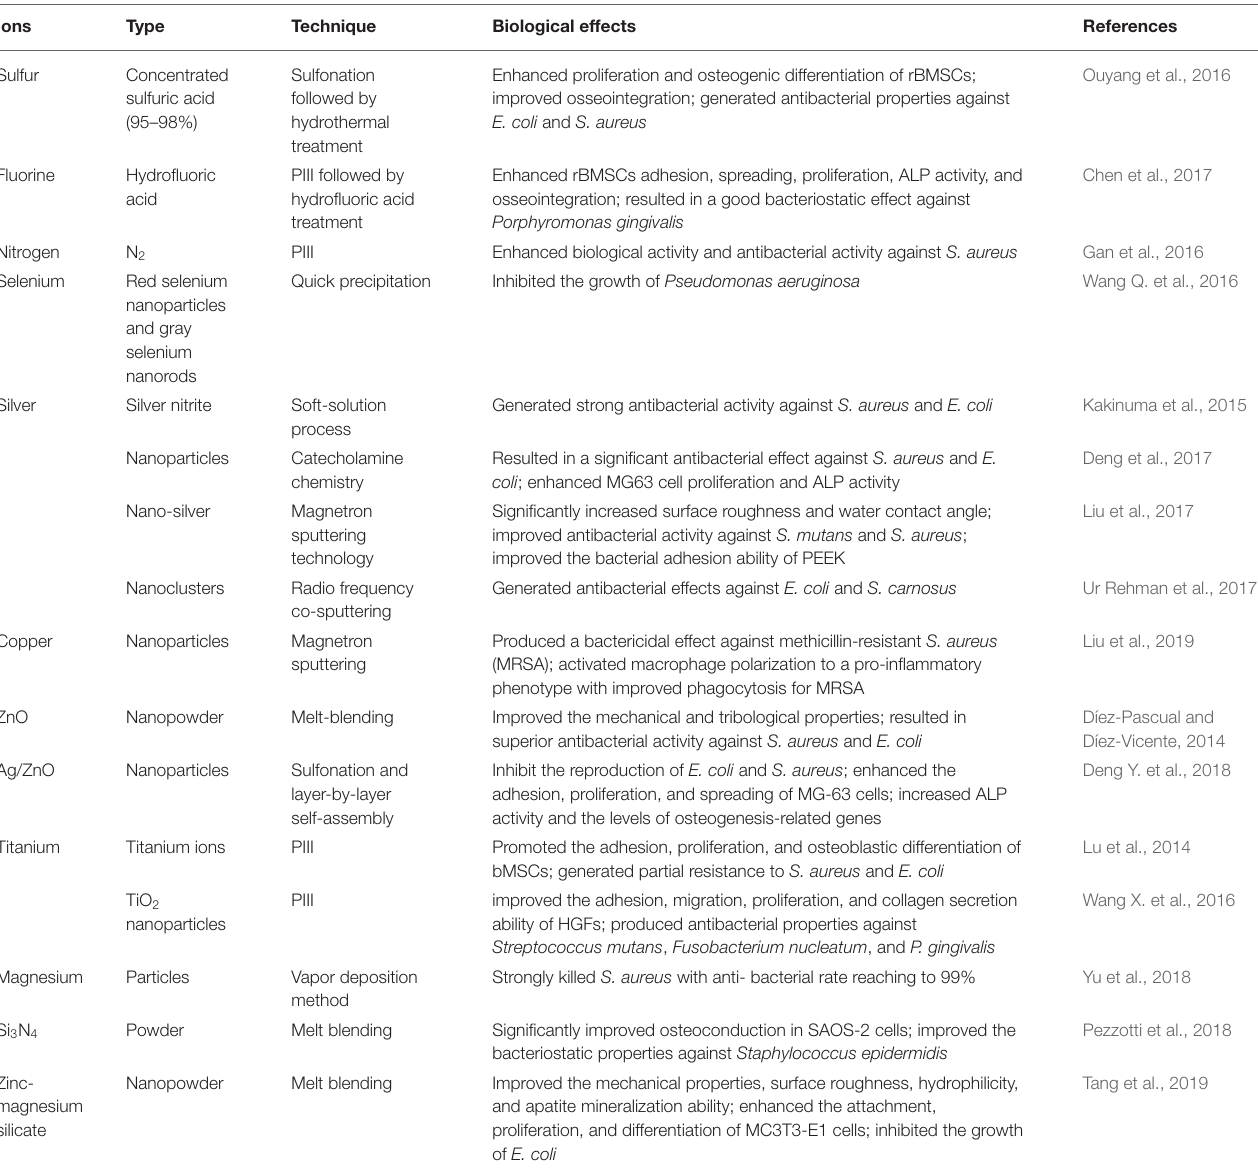
TABLE 2 | Summary of studies on antibacterial ions and their biological